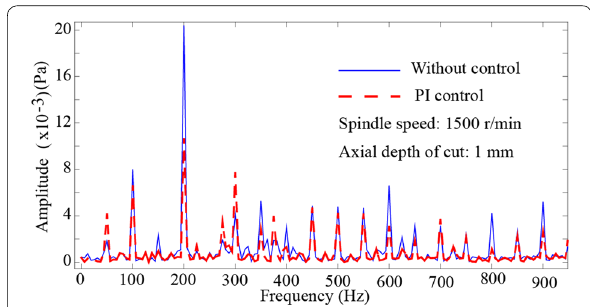
Figure 6 FFT of displacement signals at a spindle speed of 1500 r/min, radial depth of cut of 1 mm and axial depth of cut of 1 mm